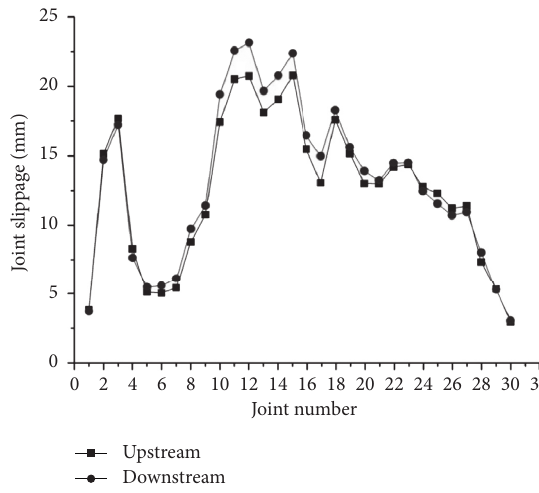
Figure 15: Joint opening at the downstream side of the dam crest under two conditions.